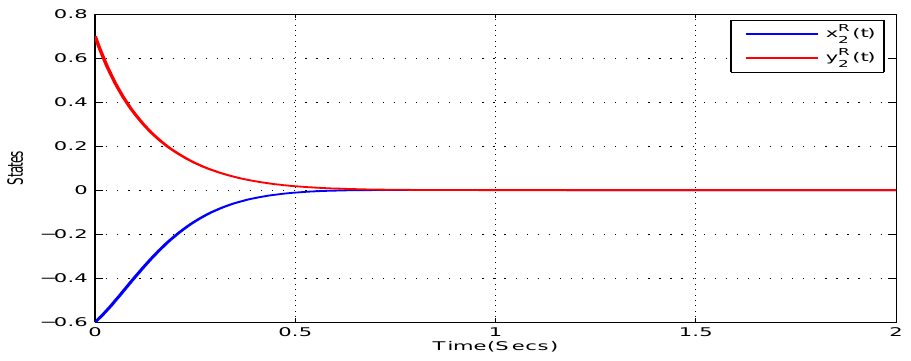
Figure 7. An illustration of the time responses with respect to the imaginary part pertaining to the states of ( t ) , y R ( t ) in Example 2. x R 2 2